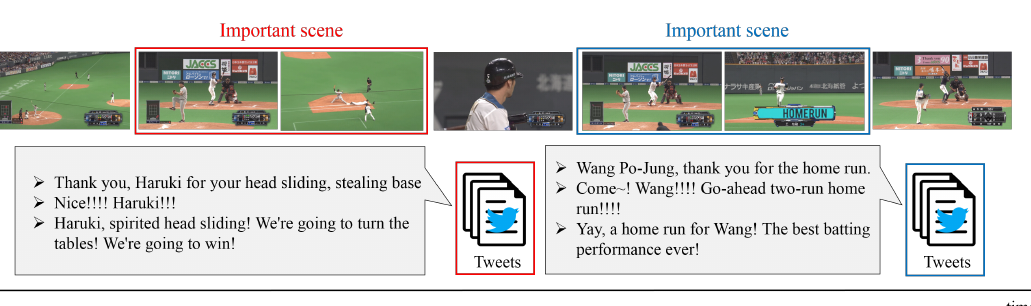
Figure 3. Two examples of important scenes detected by the Tl-MVAE and tweets corresponding to these scenes. The hori- zontal axis means time. The timing when important scenes occur and the timing when the corresponding tweets are posted are different.